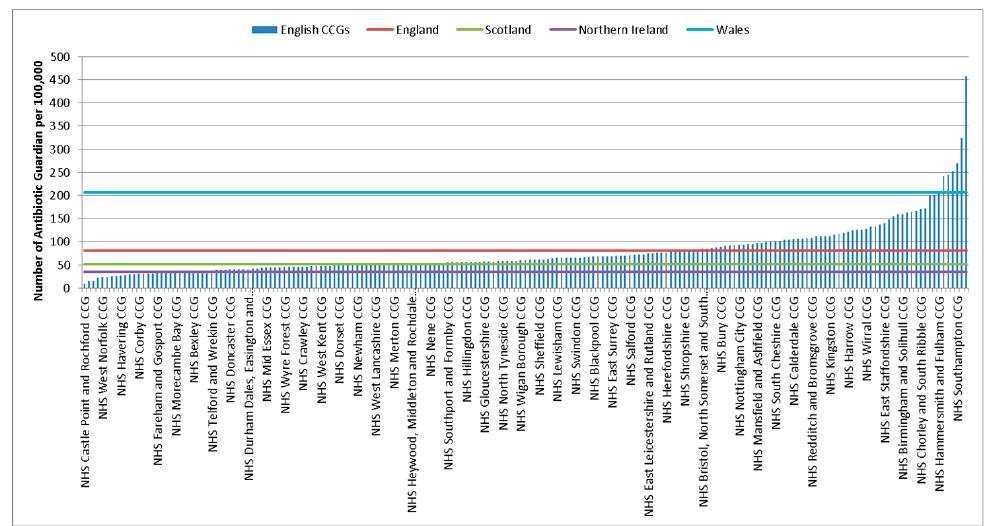
Figure 3. Rate of AGs per 100,000 population for English CCGs and Scottish, Welsh and Northern Ireland Health Boards (2014–2017).